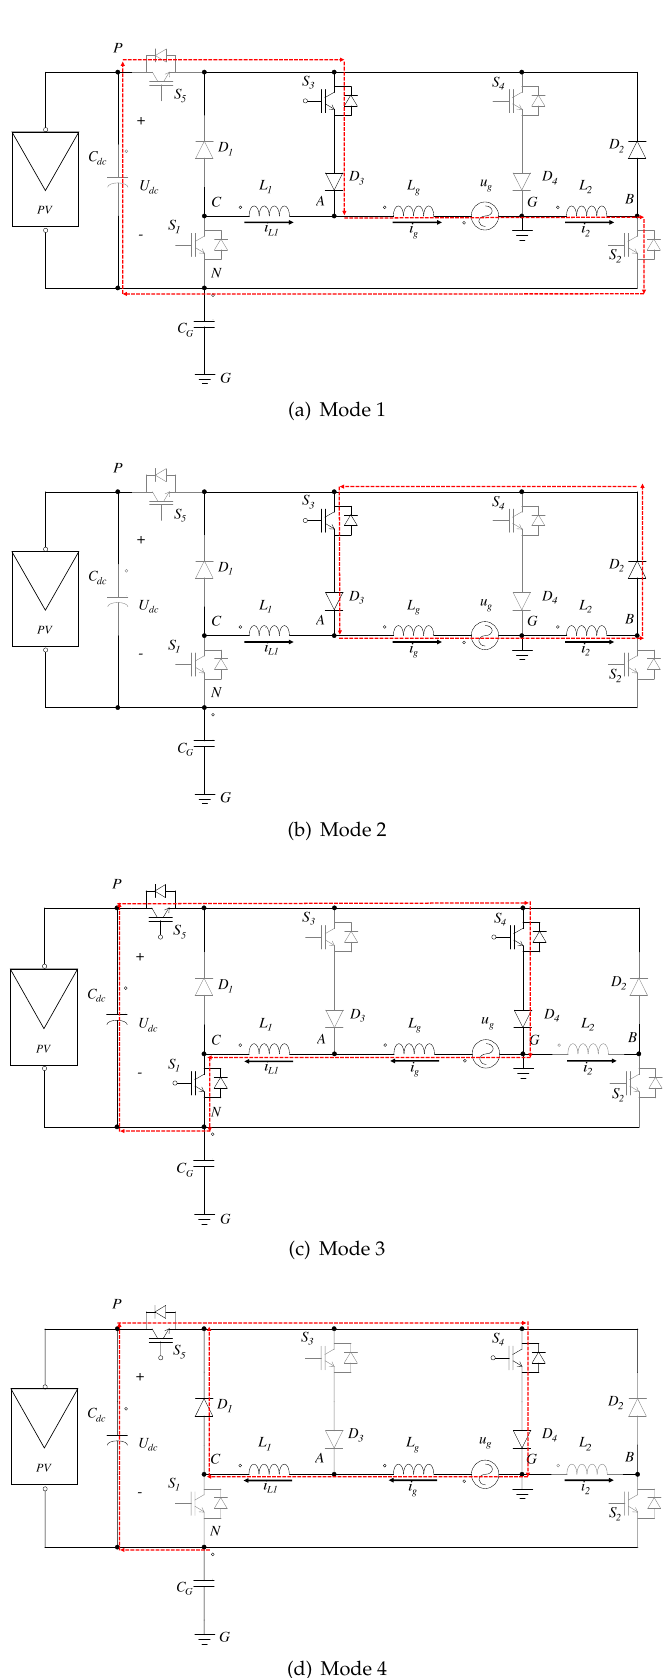
Figure 10. Operating modes and its equivalent circuits of TDFGI-H5 in Reference